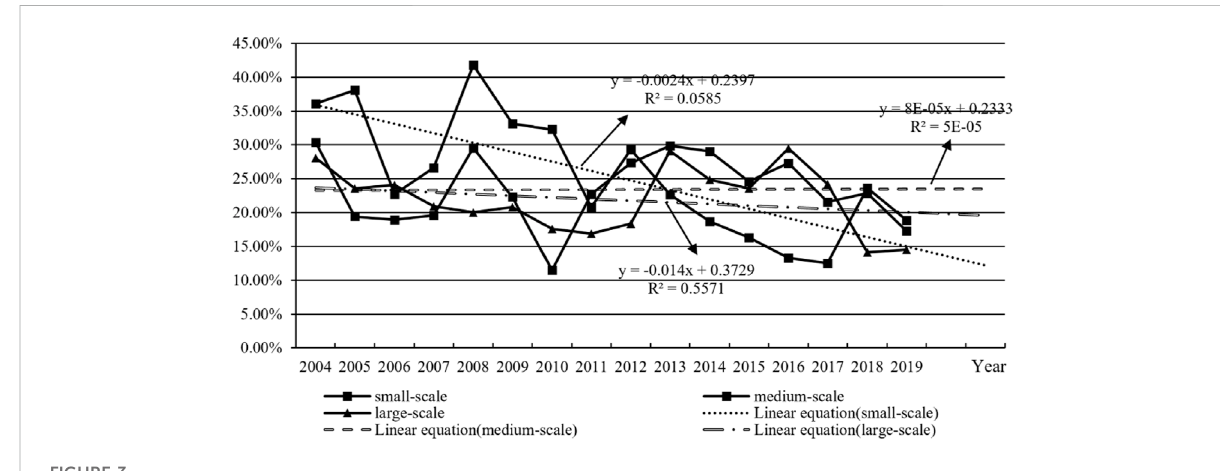
FIGURE 3 Prediction of environmental ef fi ciency improvement potential of dairy farming on different